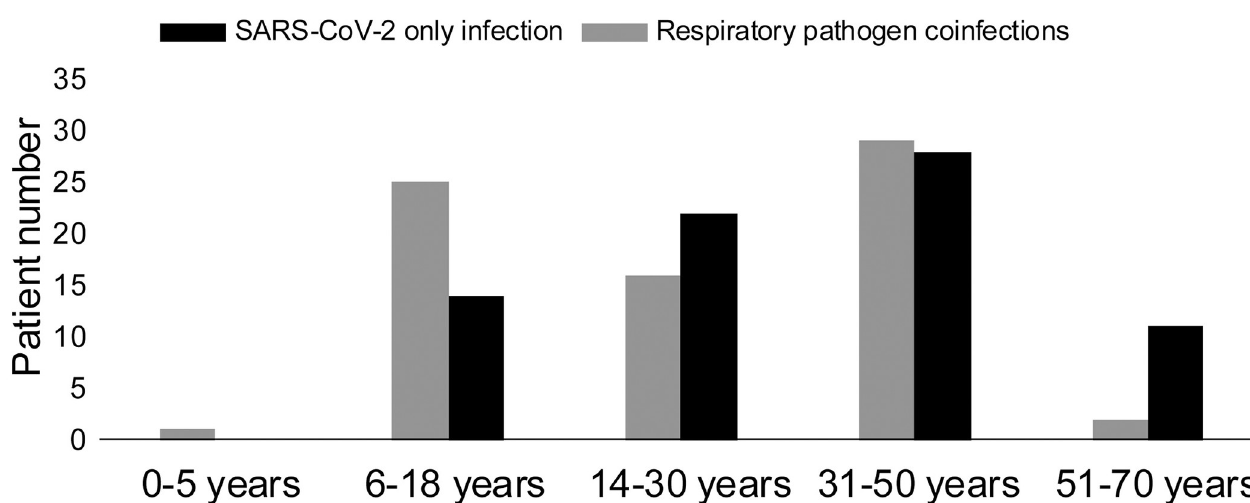
Fig 2. Age distribution of SARS-CoV-2 only infection (n = 66) vs. COVID-19 cases with respiratory pathogen coinfection (n = 67) among the study